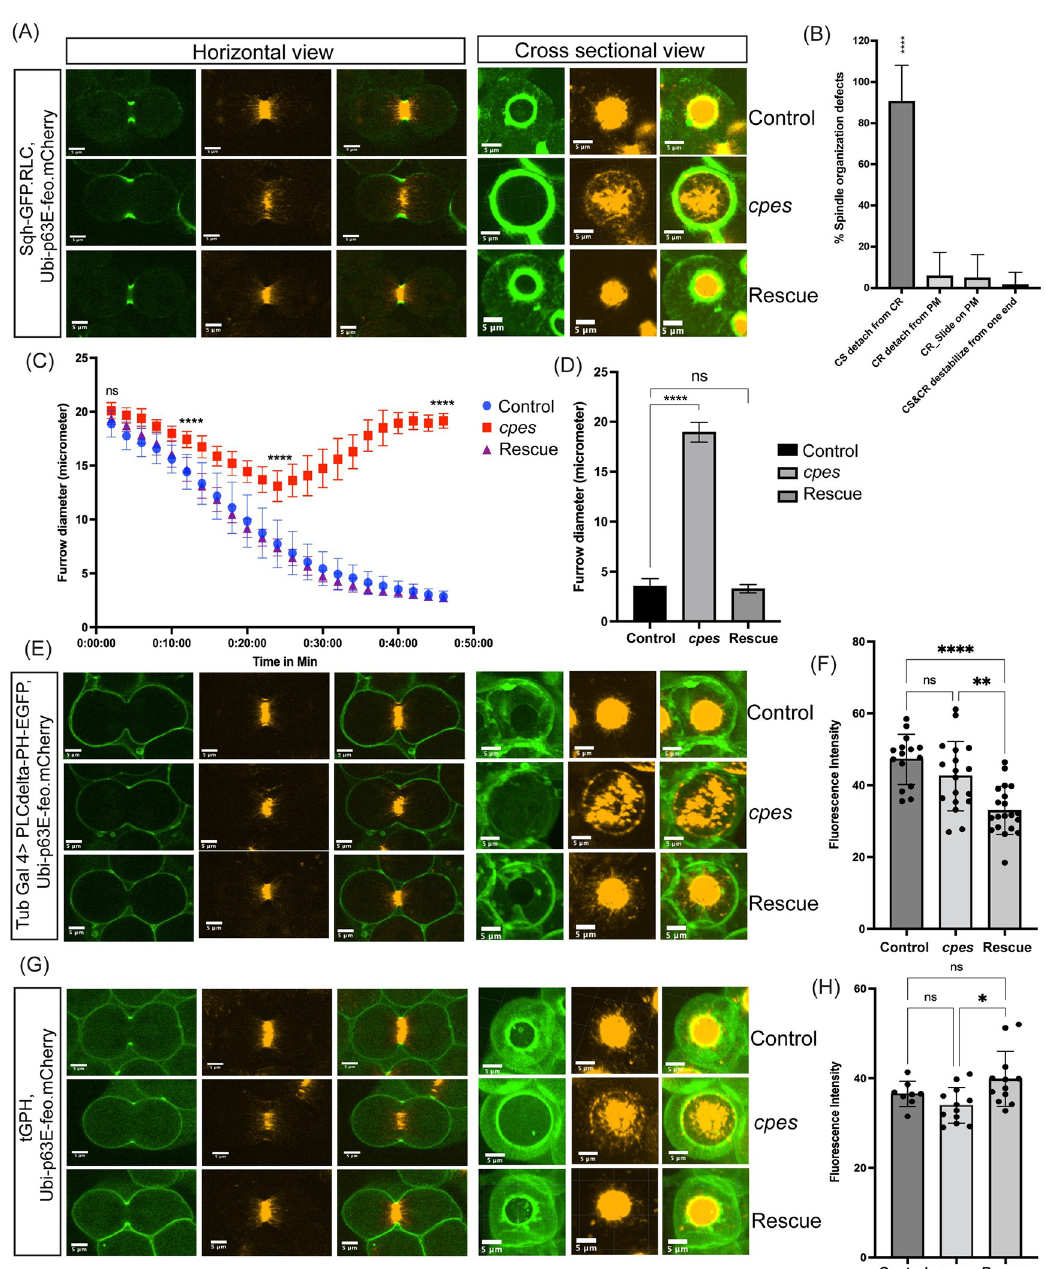
Fig 4. Aberrant central spindle behavior but not localization of PIPs at the plasma membrane is responsible for meiotic cytokinesis defect in cpes mutants. (A, C, and D) Snapshots of live spermatocytes undergoing meiosis I cytokinesis. In horizontal view (left), one slice of a z-stack is shown. In cross-sectional view across cleavage furrow, maximum intensity projection image is shown (right). Control spermatocytes (top row), cpes mutant spermatocytes (middle row), and tubulin-Gal4 > UAS-CPES rescue (bottom row). (A) Spermatocytes expressing myosin II RLC tagged to GFP under its own promoter (sqh) that localizes to contractile ring and mCherry tagged fascetto (feo) under the control of Ubi-p63E promoter that binds to central spindle microtubules. (B) Quantification of spindle organization defects in live cpes mutant spermatocytes. First observable phenotype was measured and plotted. CS detachment from CR, detachment of CR from PM, CR slides on PM and CS and CR destabilizing from end. (C) Quantification of rate and magnitude of cytokinetic furrow ingression using ImageJ and Prism9. Cytokinetic furrow diameter was measured as a function of time in dividing spermatocytes from control ( n = 12), mutant ( n = 10), and rescue sample ( n = 9). Statistics were performed using 2-way ANOVA multiple comparisons in Prism 9. (D) A representative bar diagram for cytokinetic furrow diameter at 40 min post furrow ingression in C. (E) Spermatocytes expressing GFP-tagged PH domain of PLCD (UAS-PLC δ -PH-EGFP) under the control of Tub-Gal4 that localizes to PM in the presence of